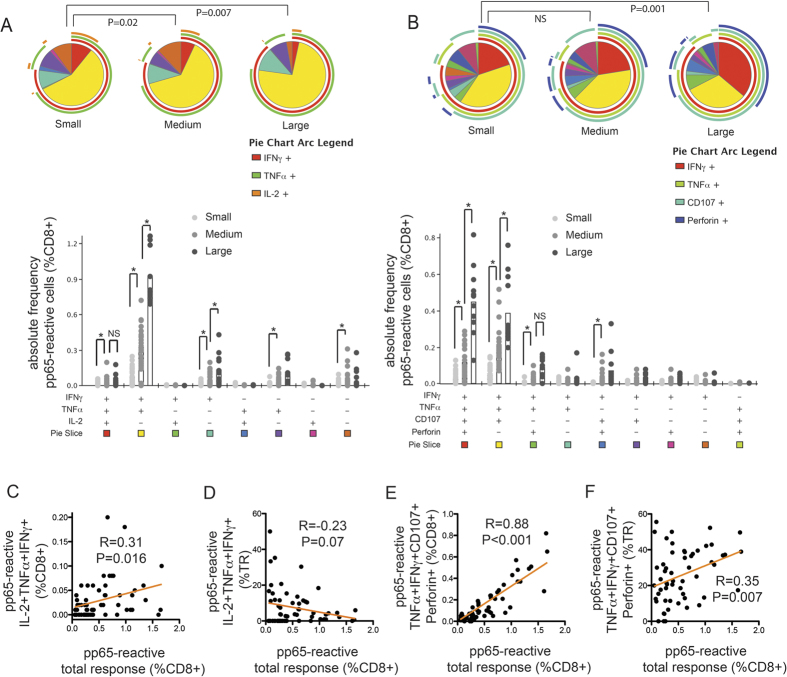
The size of the total CMV-specific CD8 + T-cell response determines its polyfunctionality profile.Based on the total frequency (%CD8+) of CMV-reactive cells among CD8 + T cells (or total response, TR), participants were separated into three response-size groups: large, >1%; medium, 0.5–1%; and small, <0.5%. Polyfunctionality was analyzed according to two different combinations (panels) of cellular expression. The first panel consisted of three cytokine effector functions associated with memory T cells: IL-2 (2), TNFα (T), and IFNγ (I) (Panel A). The second panel consisted of four effector functions associated with the cytotoxic effector phenotype: perforin (P), CD107a (C), TNFα (T) and IFNγ (I) (Panel B). Results are summarized using pie charts (showing the relative contribution of each functional subset among the total response) and bar graphs (showing the frequency of each functional subset within total CD8 + cells, %CD8). Each color slice of the pie chart corresponds to a specific functional subset shown in the corresponding bar graph. For simplicity, some subsets without any cells are hidden from the bar graphs. (A) Large, medium, and small TRs harbored different levels of IL-2-associated polyfunctionality. The I + T + 2 + subset represented a smaller proportion of the TR (shown as the red slice in the pie charts) in the large than smaller TRs. However, the frequency of the I + T + 2 + subset within total CD8 + T cells (%CD8) was higher in participants with larger TRs. (B) Different TR sizes harbored different levels of cytotoxic polyfunctionality. The I + T + C + P + subset constituted a larger proportion of the large TR than it did in the small TR. The large TR at the same time also comprised a higher frequency of I + T + C + P + cells within total CD8 + T cells (%CD8) (shown as the red slice in pie charts). (C) Linear regression analysis showed that the I + T + 2 + subset frequency (%CD8) positively correlated with TR size. (D) However, the proportion of I + T + 2 + subset within TR negatively correlated with TR size. (E,F) Both the I + T + C + P + subset frequency (%CD8) and its proportion within TR positively correlated with TR size.